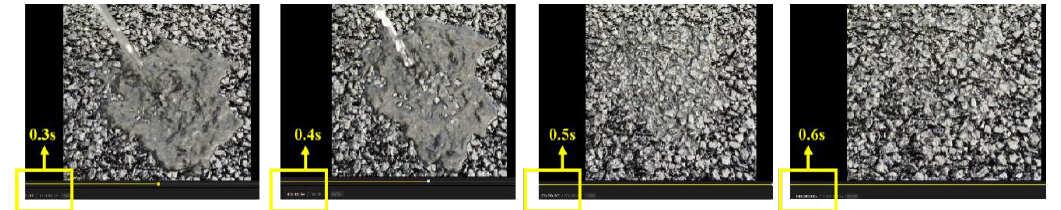
Figure 19. Drainage test.